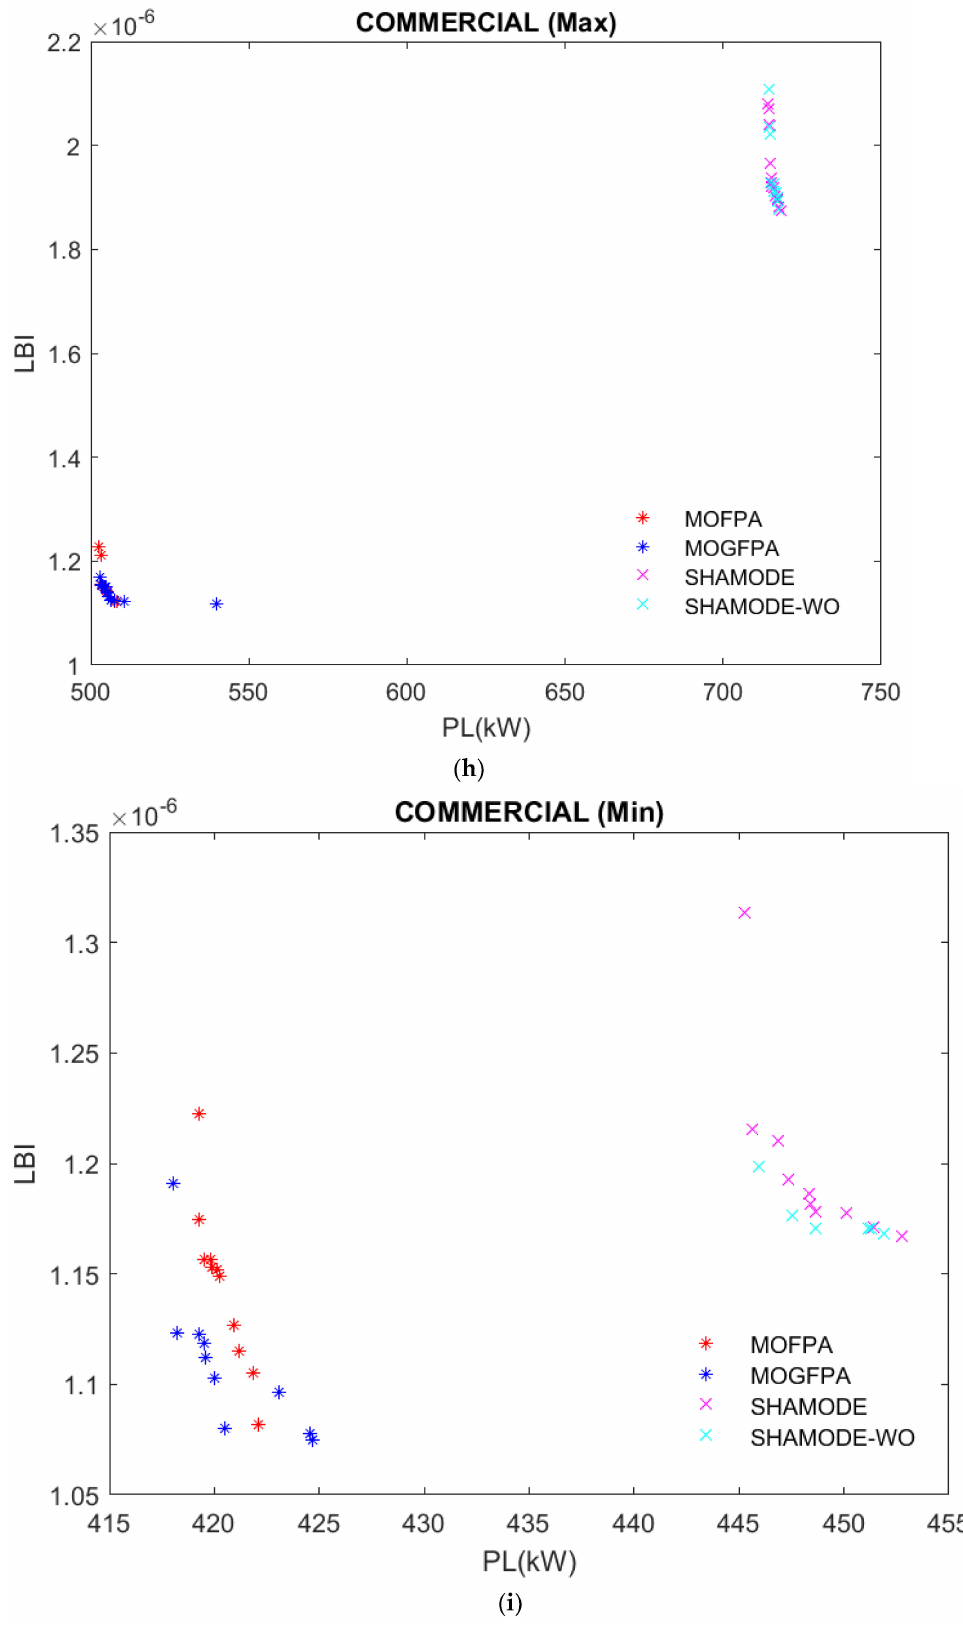
Figure 7. ( a ) Comparative analysis of average LBI and PLs for residential loads; ( b ) Comparative analysis for maximum LBI and PLs for residential loads; ( c ) Comparative analysis for minimum